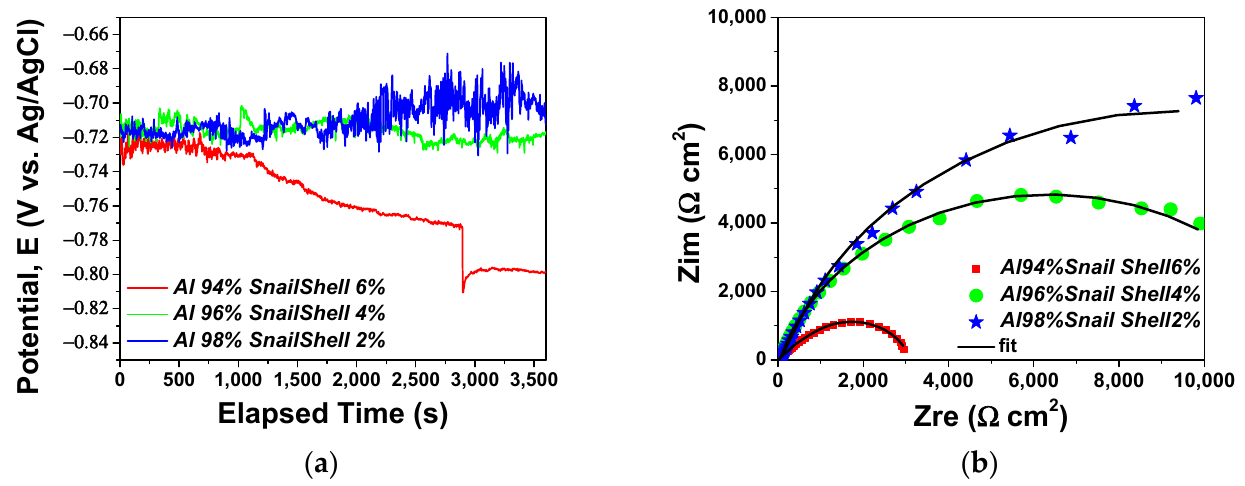
Figure 4. ( a ) Evolution of the open circuit potential and ( b ) Nyquist plot of the investigated specimens (Scatter line—measured data, continuous line—fitted data).